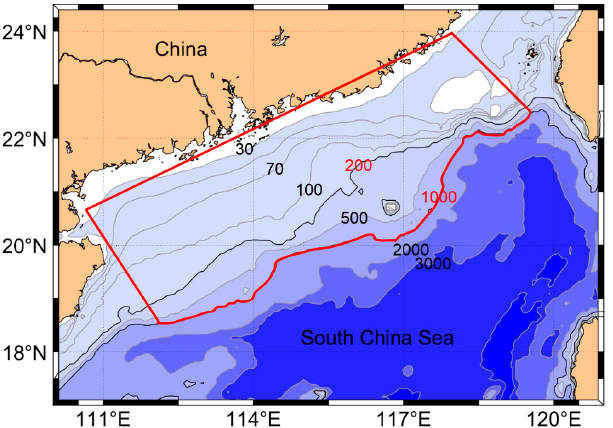
Figure 1. Topographic map of the continental shelf in the northern SCS. The red curve indicates the study area. The numerals on the isobaths are in m.